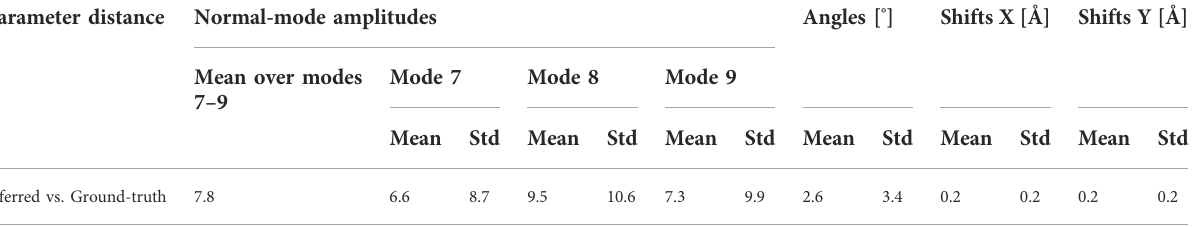
Inferred vs. Ground-truth